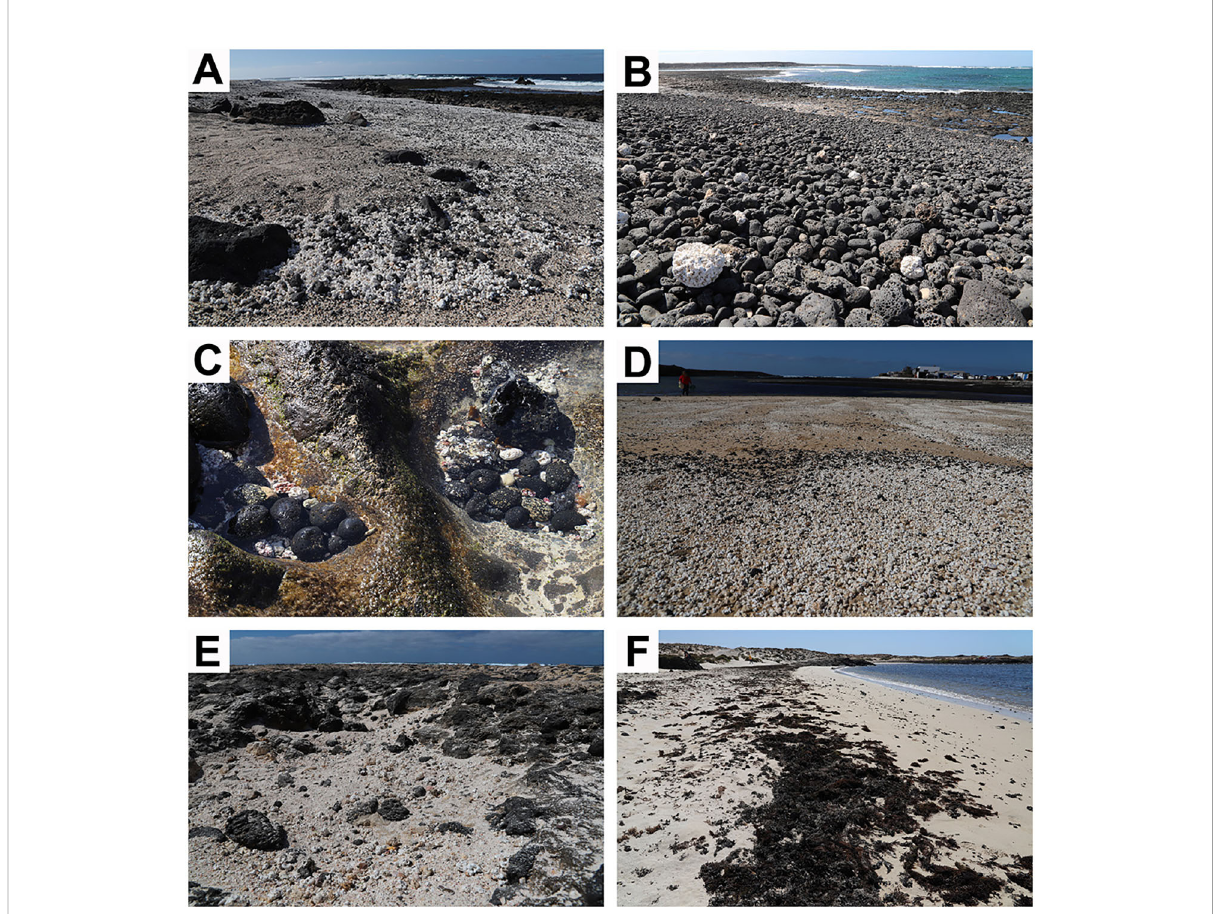
FIGURE 3 Field photos of stranded rhodoliths. (A) L2 - Caleta del Bajo de Mejillones, (B) L3 - Majanicho berm, (C) L3 - Majanicho intertidal pool, (D) L3 - Playa El Majanicho, (E) L4 - Playa El Hierro, (F) L5 - Caleta de